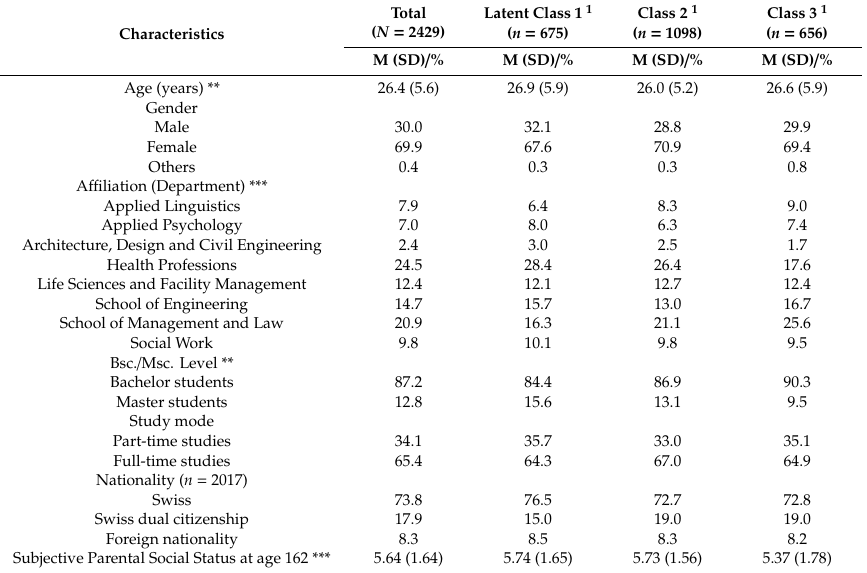
Table 1. Participants’ characteristics by latent classes.